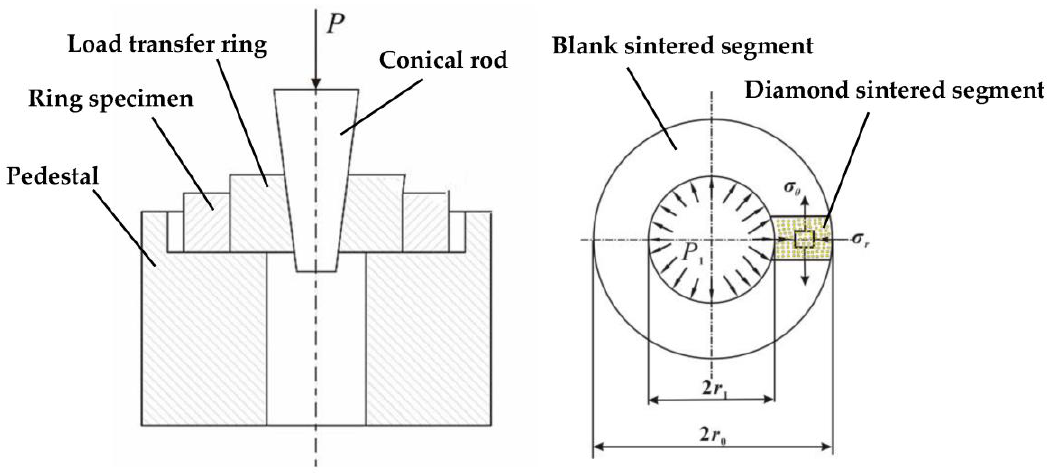
Figure 9. Schematic diagrams of tension ring test and the force conditions of tension ring specimen.